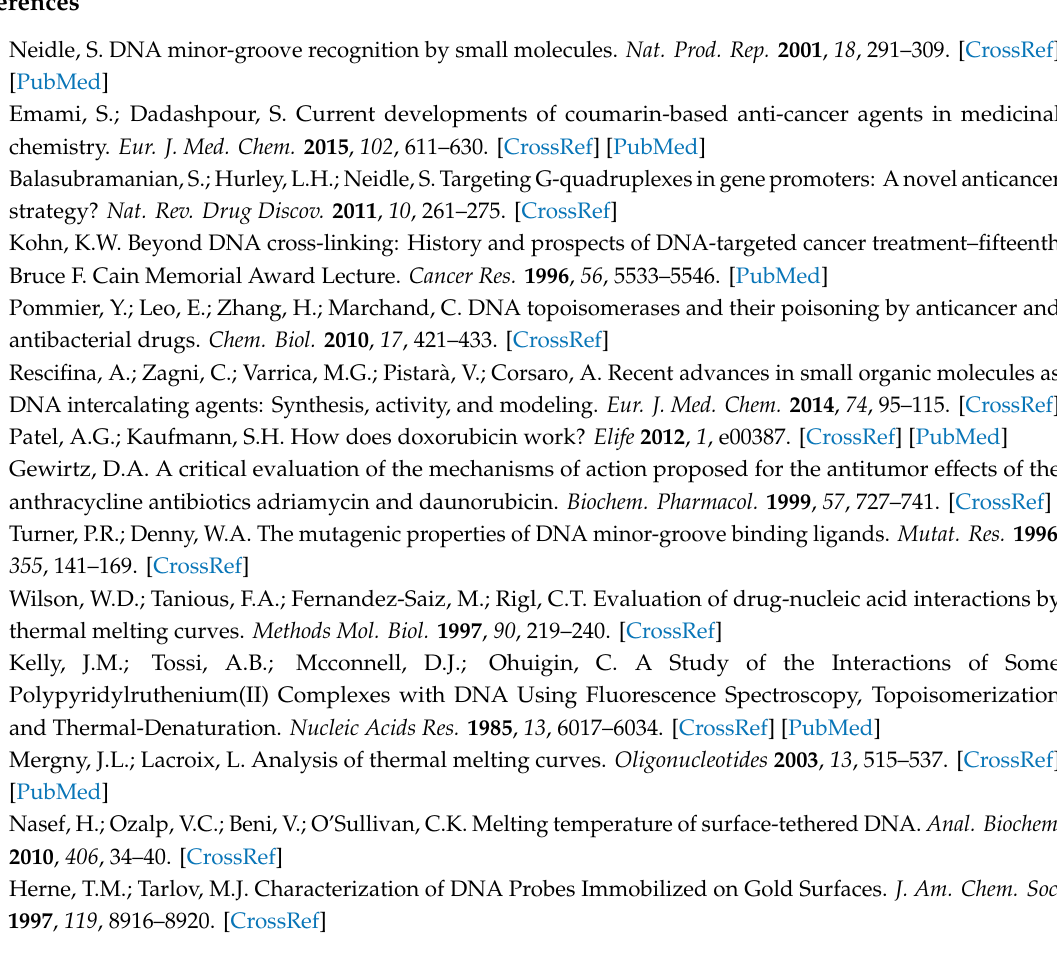
Figure S1: Calibration curve of platinum microheater / PRT, Figure S2: Photo of the assembled platform for thermoelectric heating, Figure S3: Full temperature program of platform in a melting experiment, and Figure S4: Duplex melting curves on two di ff erent devices on the same